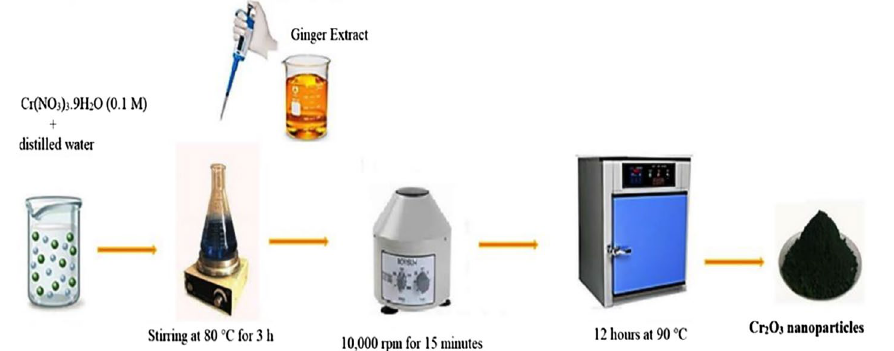
Figure 5. The stepwise synthesis pathway of Cr 2 O 3